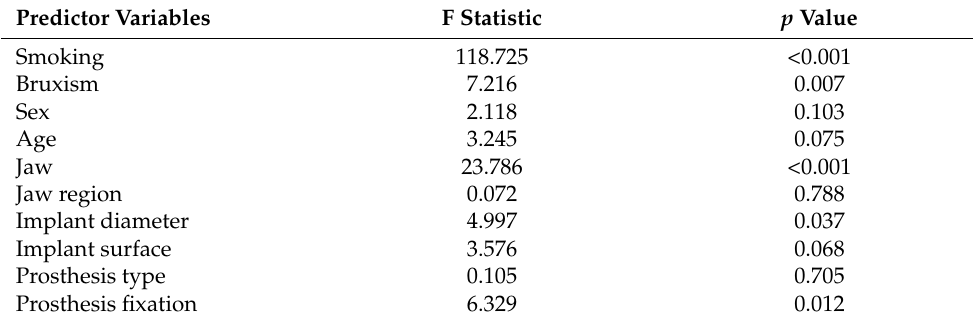
Table 4. Linear mixed-effects model for